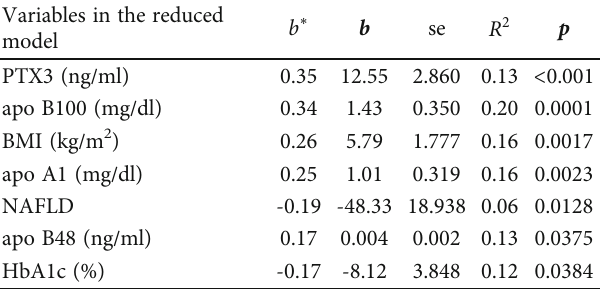
Table 5: Results of multiple backward stepwise regression analysis with PCSK9 as dependent variable in the whole group of patients.